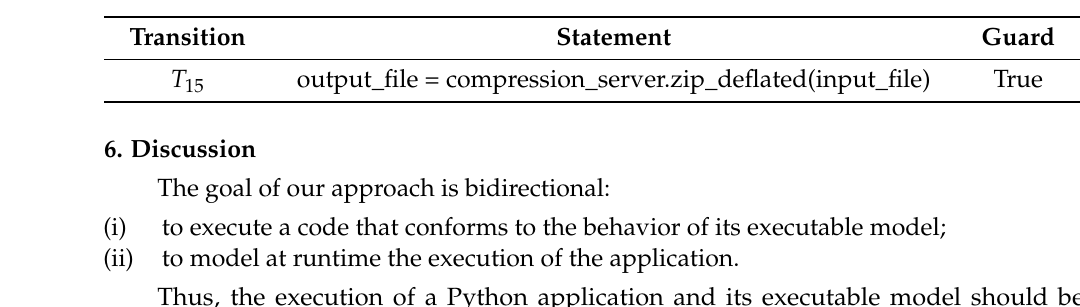
Table 5. Statements and guards of the new transition of the case